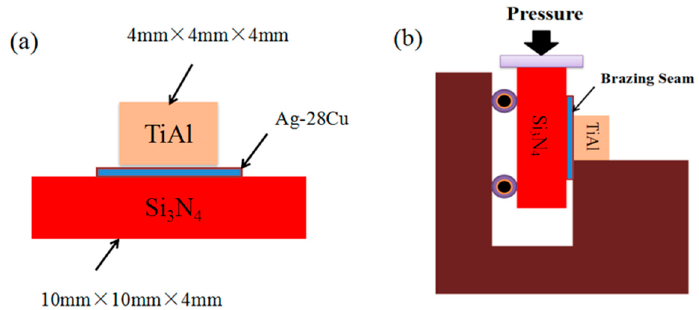
Figure 1. Schematic drawing of: ( a ) Brazing assembly; ( b ) shear test.